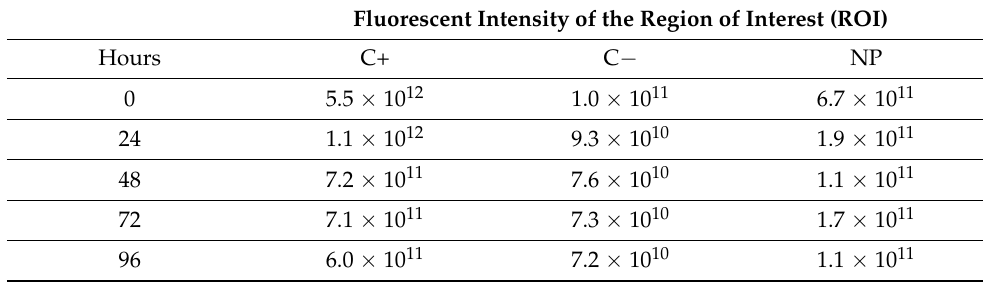
Table 1. Fluorescent intensity of the region of interest (ROI) over time, showing the specific average values of the fluorescence intensity for all time points. Fluorescent Intensity of the Region of Interest